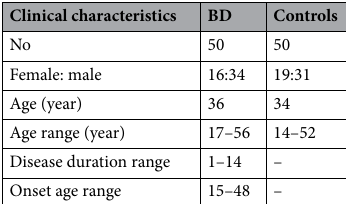
(Table 3). Post hoc power calculation using Clincalc online tool (https:// clinc alc. com/ stats/ Power. aspx) and expression values of lincRNA-p21 (which had the lowest fold change value in cases versus controls among all lncRNAs) showed that study power was more than 80%. Our study showed that the expression level of lincRNA- p21, lncRNA-ROR, and lincRNA-PINT in BD patients were significantly down-regulated (Fig. 1 A-C). Sig- nificant differences in expressions of lincRNA-p21 (P = 0.01), lncRNA-ROR (P = 0.0001), and lincRNA-PINT (P = 0.0012) were seen between male patients and male controls. However, the difference in expressions of these lncRNAs was not statistically significant between female subjects. The relative expression (fold change) of lncR- NAs in patients and healthy individuals are presented in Table 3. Analysis of the relationship between the expression levels of genes. This study calculated the correlation between expression levels of all genes pairs with the Pearson correlation test. The results of this com- parison are included in Table 4. We found a significant positive correlation between expression levels of all genes